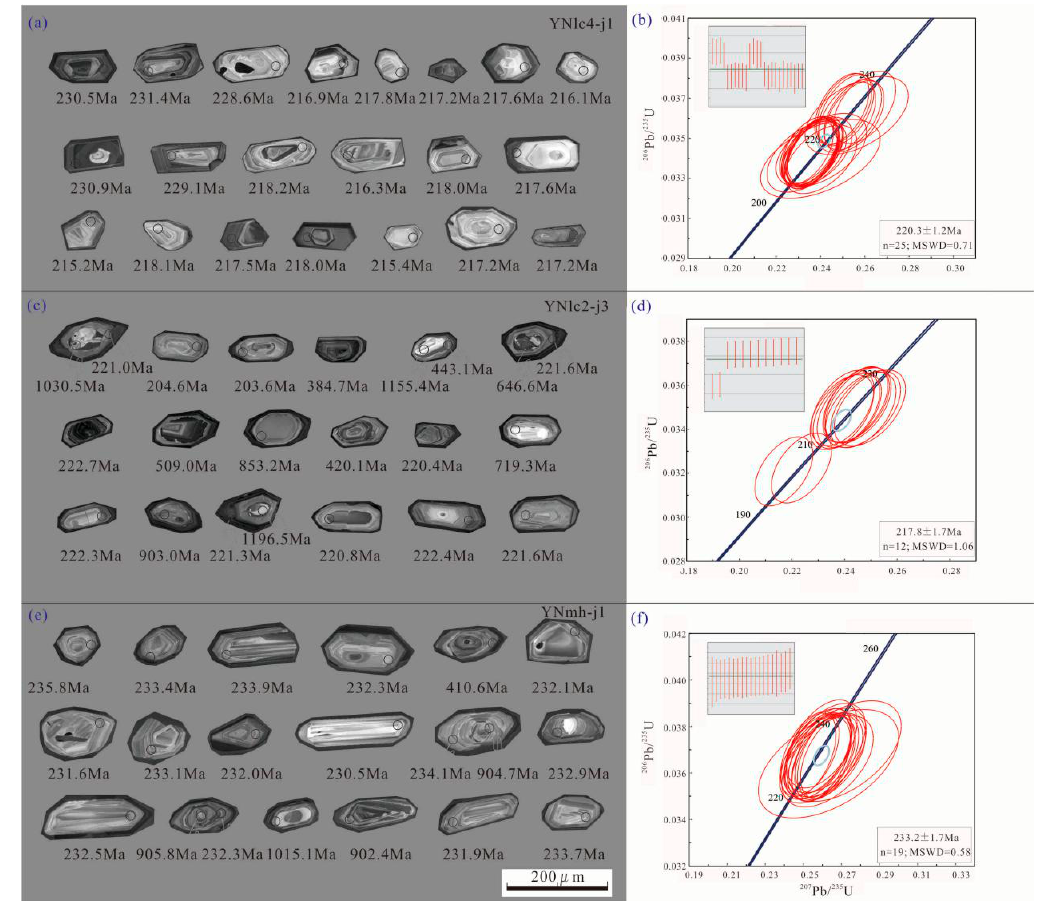
Fig.8 Cathodoluminescence (CL) images of representative zircon grains (a, c and e) and LA-ICMPS zircon U-Pb weighted age Figure 8. Cathodoluminescence (CL) images of representative zircon grains ( a , c , e ) and LA-ICP-MS diagram for the Lincang monzonite granite (b, d and f) from the Lincang monzogranite granite zircon U-Pb weighted age diagram for the QN and MH granites ( b , d , f